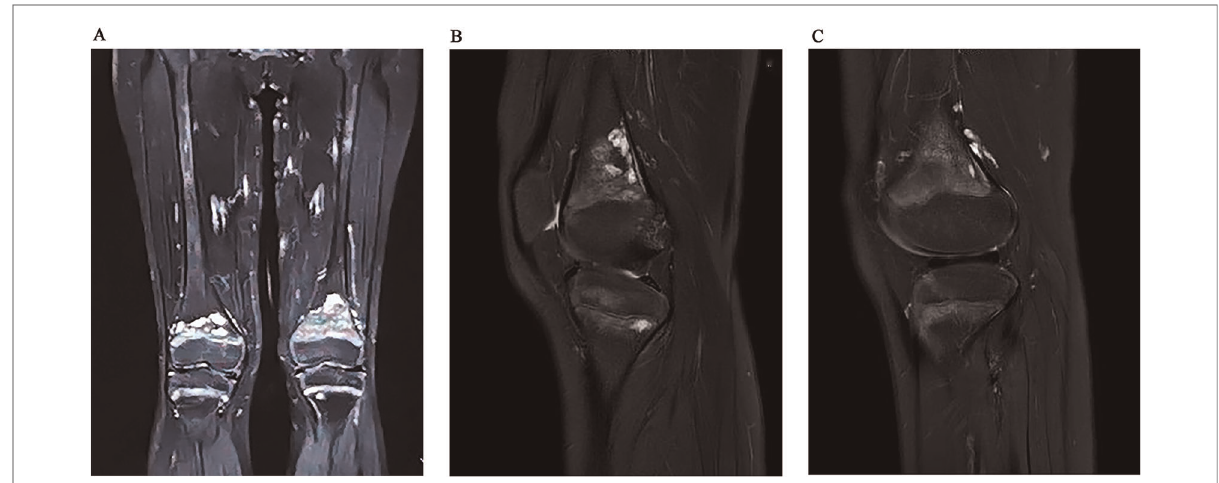
FIGURE 2 Coronal ( A ) and sagittal ( B ) MRI images indicated that lump-shaped shadow with long T1 and T2 signal was observed in the bottom of the femurs and in the upper end of tibias on both sides, no abnormality was observed in the shape and signal of the medial and lateral meniscus. After 6 months follow-up, we could see that the lesion was smaller than before ( C